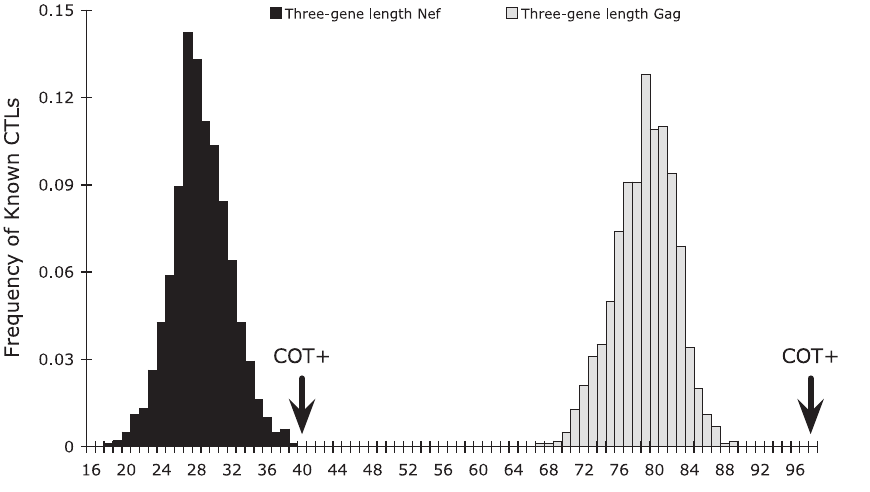
Figure 4. The Distribution of the Number of Known Epitopes in Three Randomly Chosen Gag (Right-Side Distribution) and Nef (Left-Side Distribution) Genes from the Los Alamos National Laboratory Database The COT þ sequence at three gene lengths for Gag has 98 out of 102 known CTL epitopes, and Nef has 40 out of 49 known CTL epitopes.